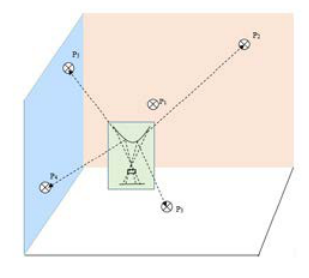
Figure 9: Indoor